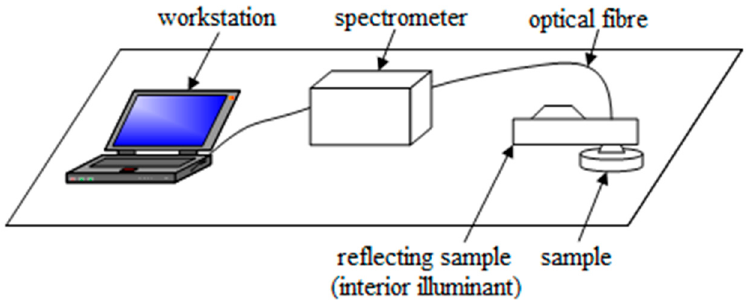
Figure 1. The indoor spectral acquisition system.